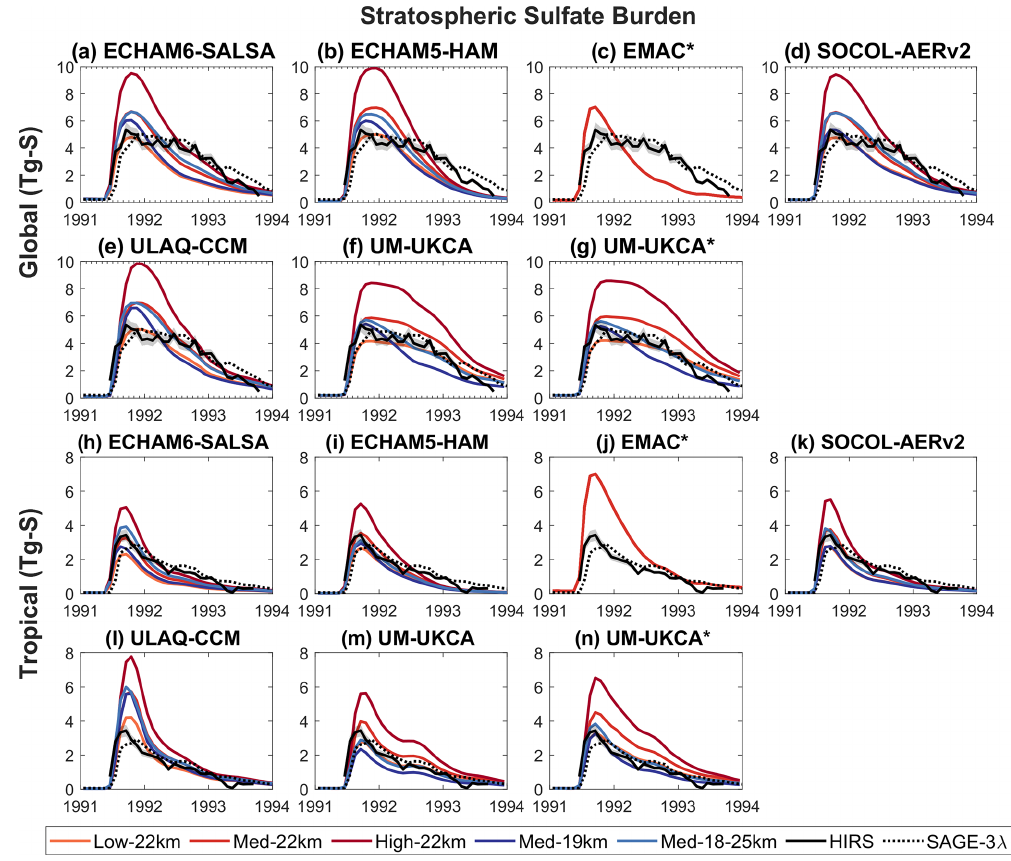
Figure 5. Time evolution of monthly values of global and tropical stratospheric sulfate burden in teragrams of sulfur (first and second column, respectively). Each panel refers to the respective model in which the different results of the experiments (colored lines; different line styles for different experiments; see legend on the left) are compared with the HIRS and SAGE-3 λ data sets (black lines; see legend on the right). ∗ Models with spatially spread SO 2